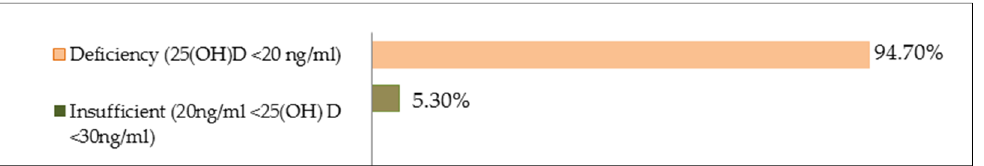
Figure 2. Vitamin D status in women participant in the study ( n = 152).